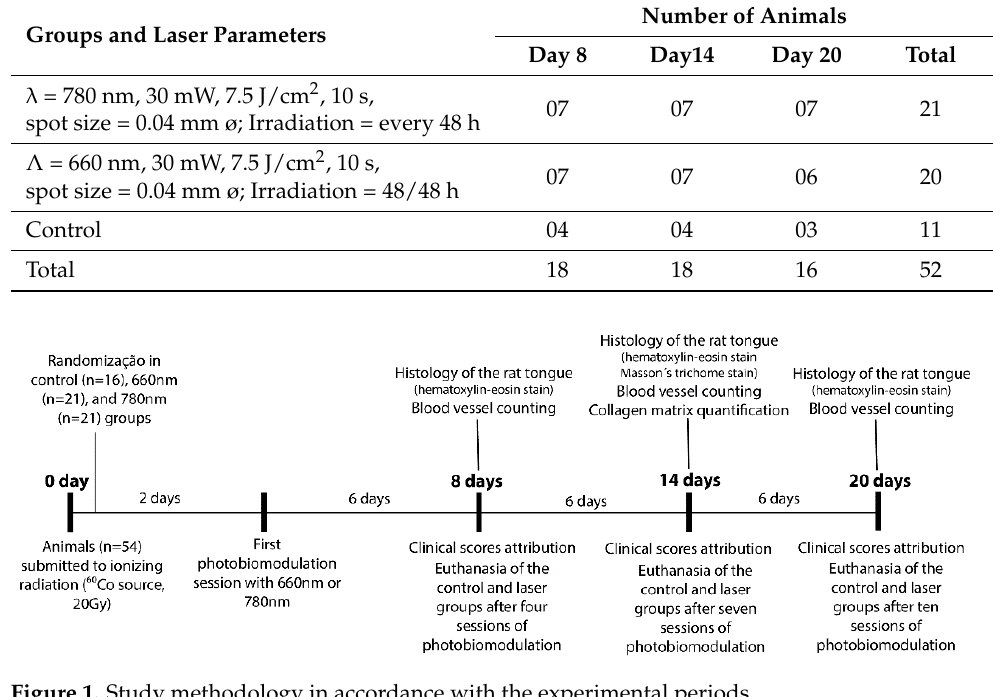
Table 1. Laser parameters and number of animals in each experimental period. Groups and Laser Parameters